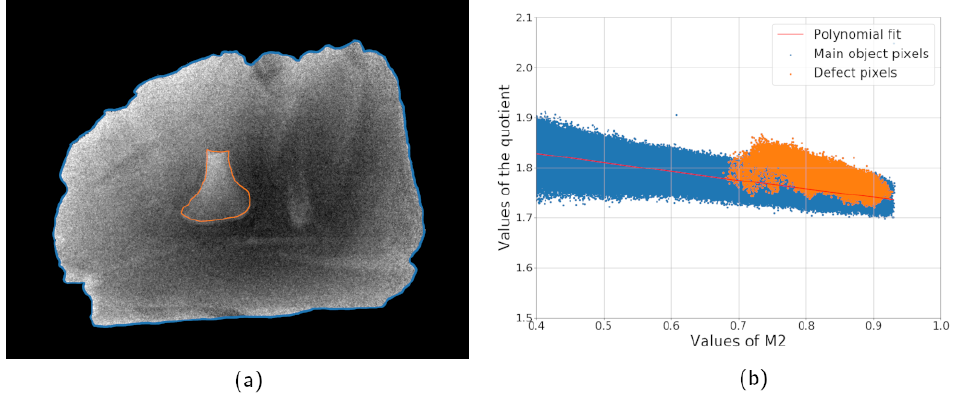
Figure 4. Sample scan with high exposure (5 s per projection): combined image computed according to Equation (5) ( a ) and the dependency of its values on the single projection intensity ( b